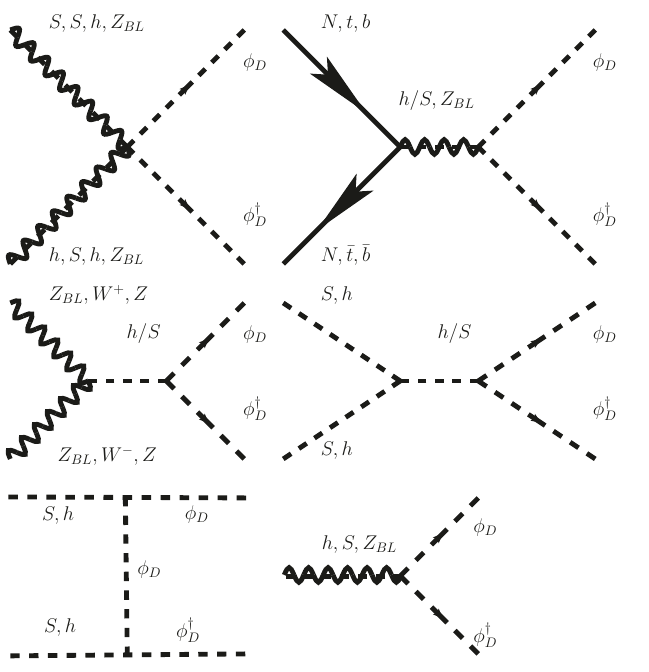
Figure 3 . Production channels of dark matter φ D . The channels with Z BL , as well as the t channel contributions give negligible contributions for our